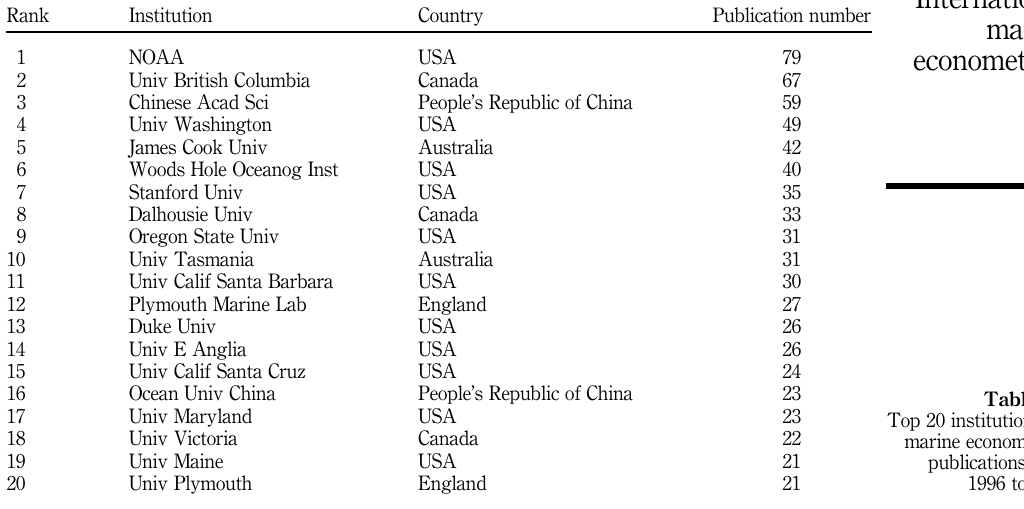
Table IV. Top 20 institutions for marine econometrics publications from